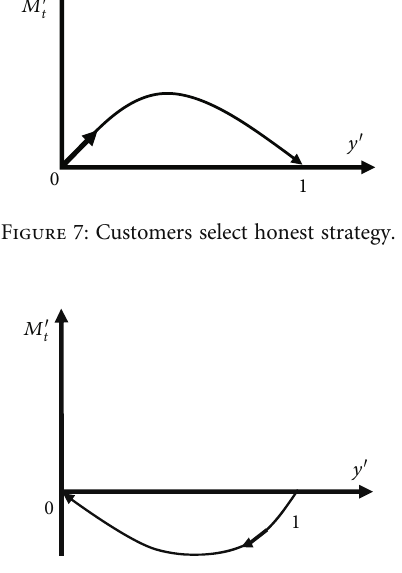
Figure 8: Customers select dishonest